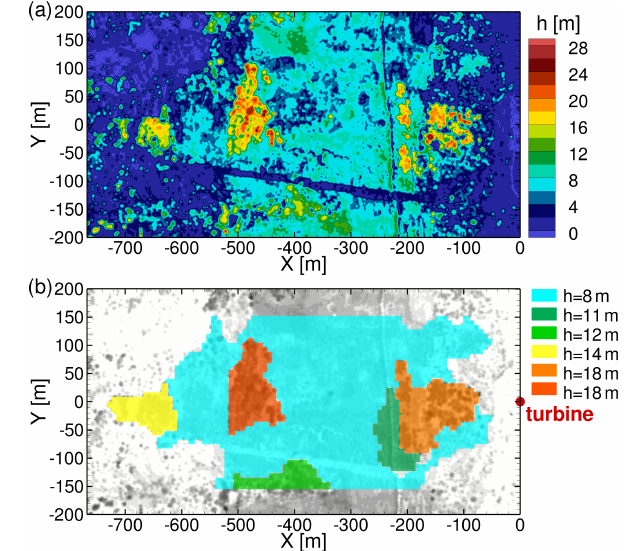
Figure 3. Tree height in the area upstream of the turbine for a wind direction of 230 ◦ (a) and forest patches included in simulation (b) . Table 1. Tree height h , leaf area index LAI, maximal leaf area den- sity LAD m and corresponding height z m for each forest patch.